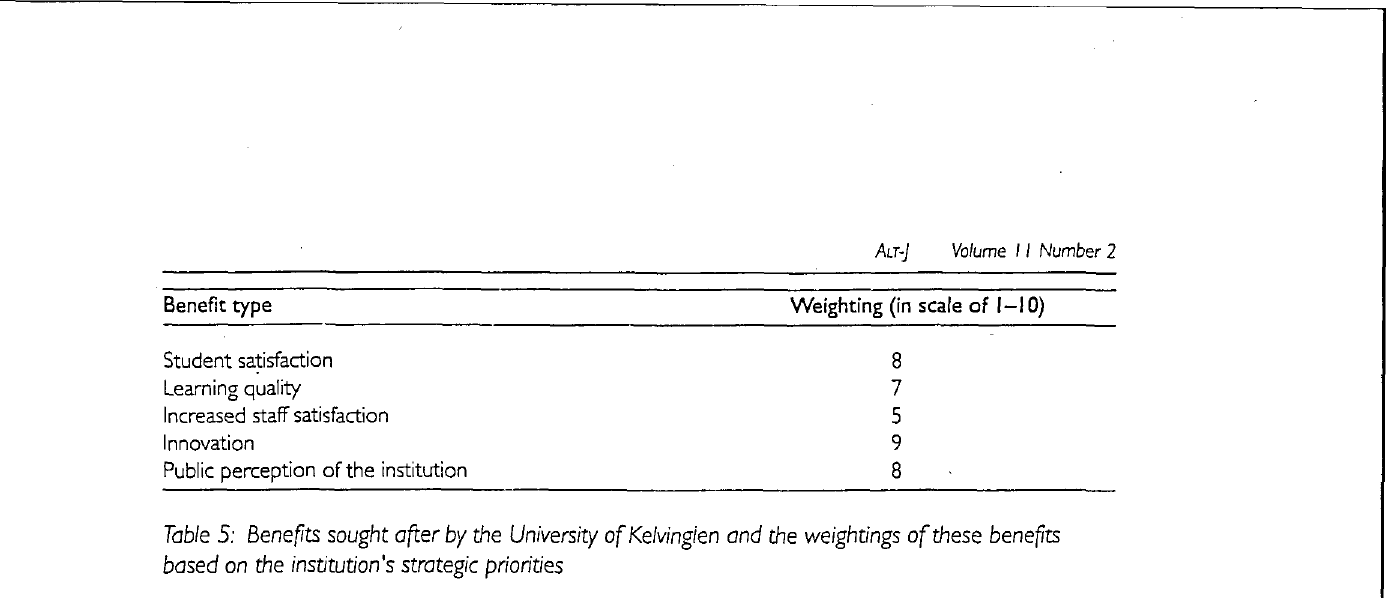
Table 5: Benefits sought after by the University ofKeivingien and the weightings of these benefits based on the institution's strategic priorities